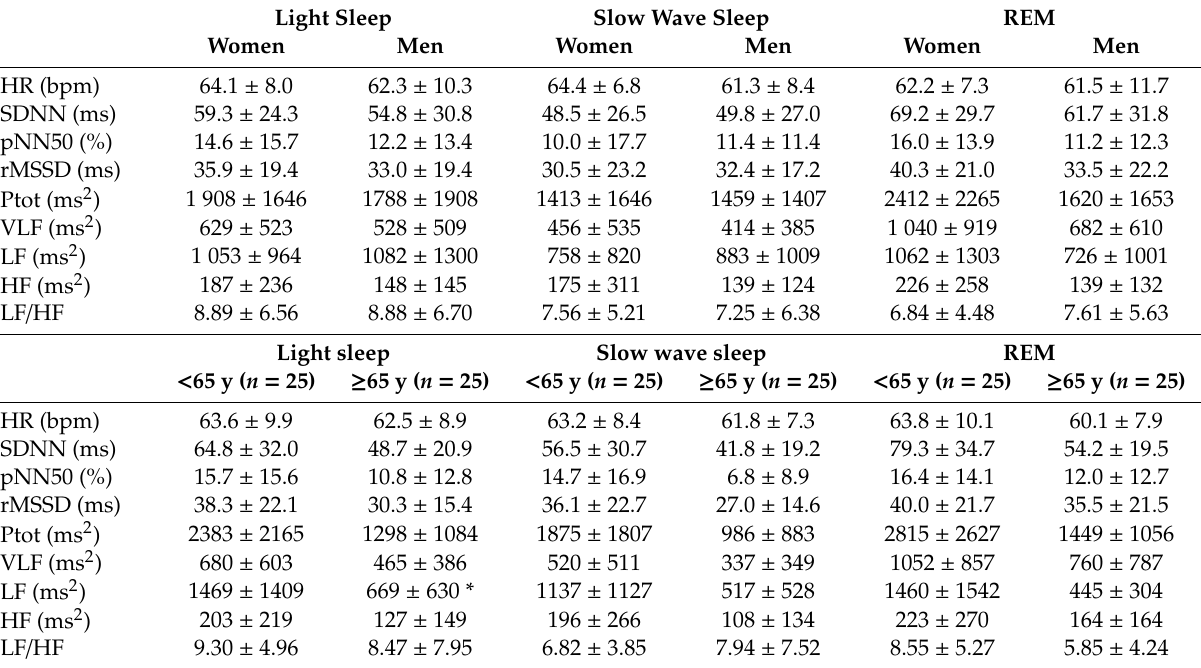
Table 3. Heart rate variability indices during periods with PLMS according to sex and age (means ± SD). Light Sleep Slow Wave Sleep